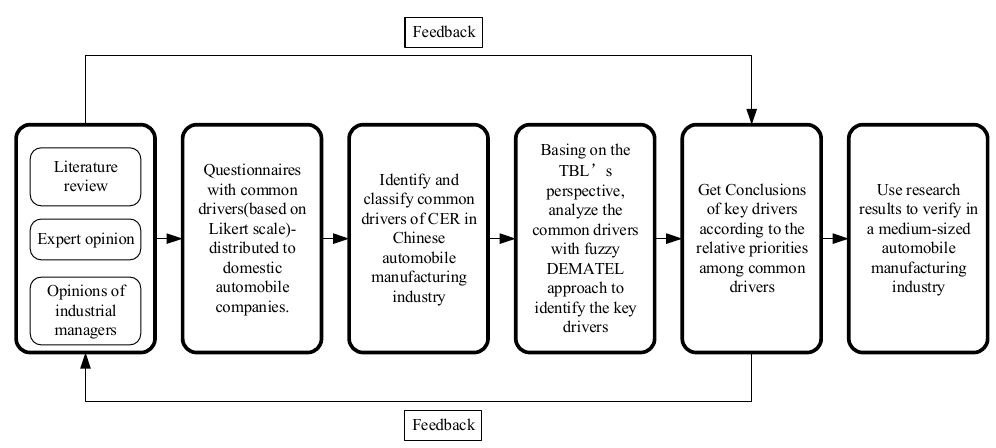
Figure 1. The model framework for analyzing the drivers of CER in Chinese auto industry.